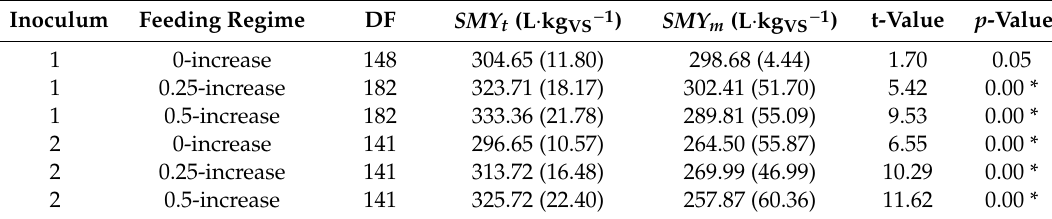
Table 4. The results of analysis on inhibition in specific methane yield ( SMY ). Feeding regime expresses the N-increase rate in a feeding ratio. Degrees of freedom (DF). SMY t and SMY m are the theoretical and measured values of specific methane yield, respectively. Gas volumes are given under standard temperature and pressure conditions (0 °C, 101.325 kPa). Units are given in square brackets. Values of SMY t and SMY m are given as mean; the standard deviation is given in round brackets.